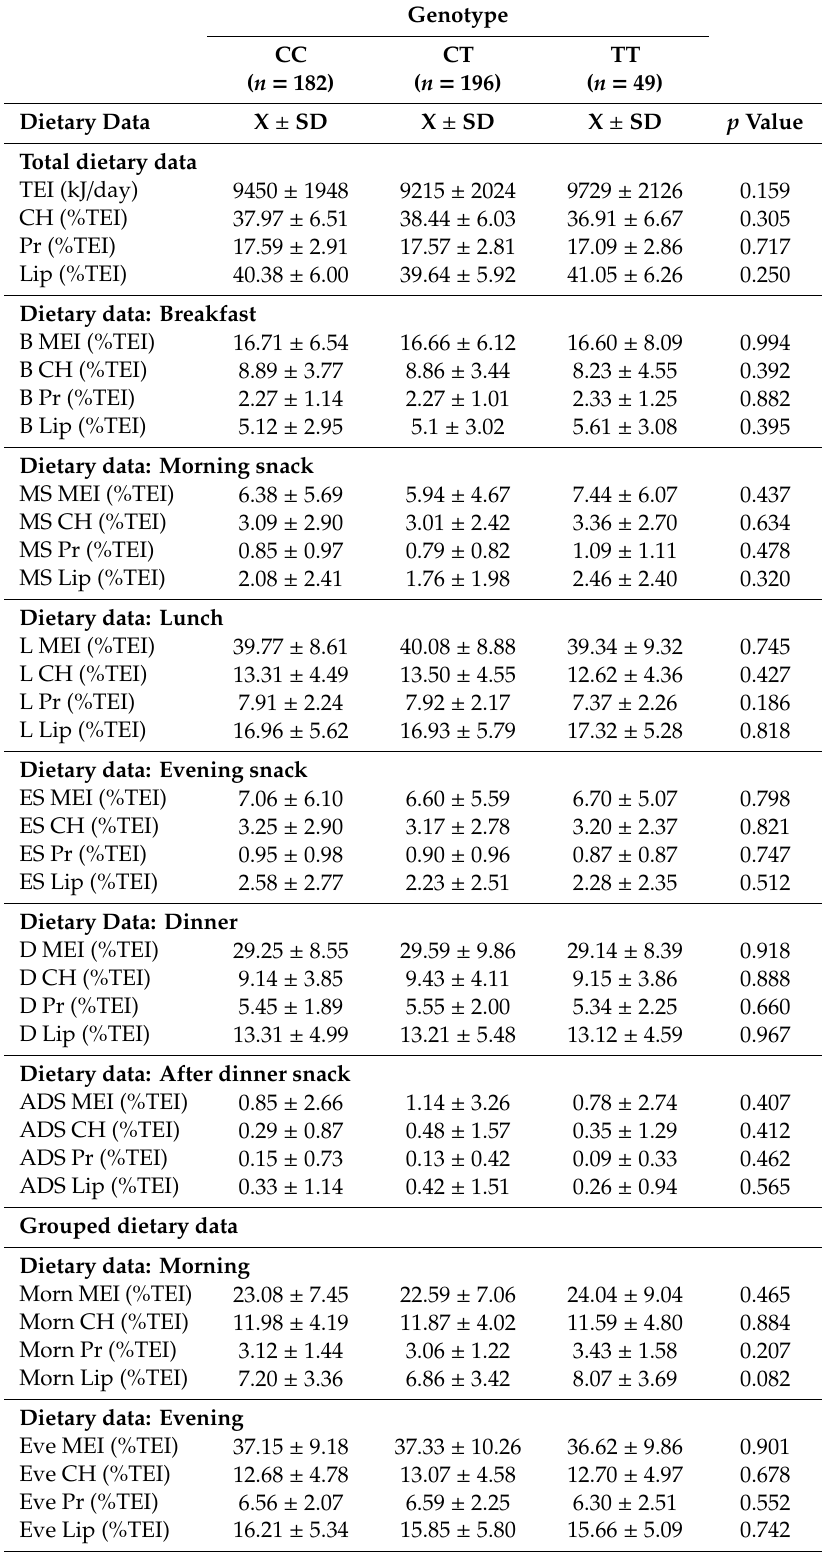
Table 2. Dietary data for the total and the time-of-day intakes by genotype of the rs3749474 (plausible